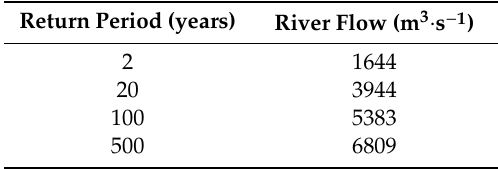
Table 3. Return periods and river flow.